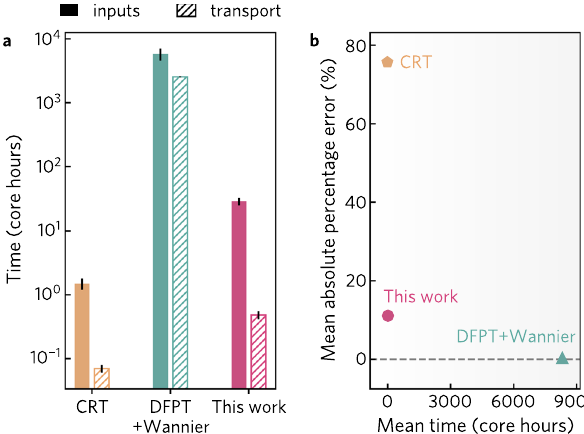
Fig. 2 Comparison of speed against accuracy for transport